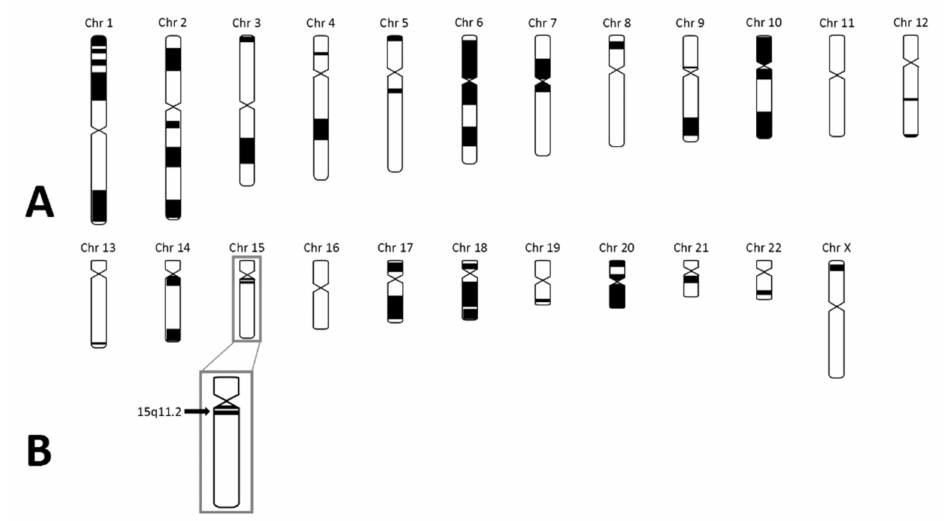
Figure 3. SNP array results in the index case. ( A ) Black parts represent homozygous regions in the index case. The number of homozygous regions is suggestive for high-grade consanguinity. ( B ) The black arrow represents 15q11.2 in which SNURF-SNRPN is located. As shown, SNURF-SNRPN lies within a homozygous region.